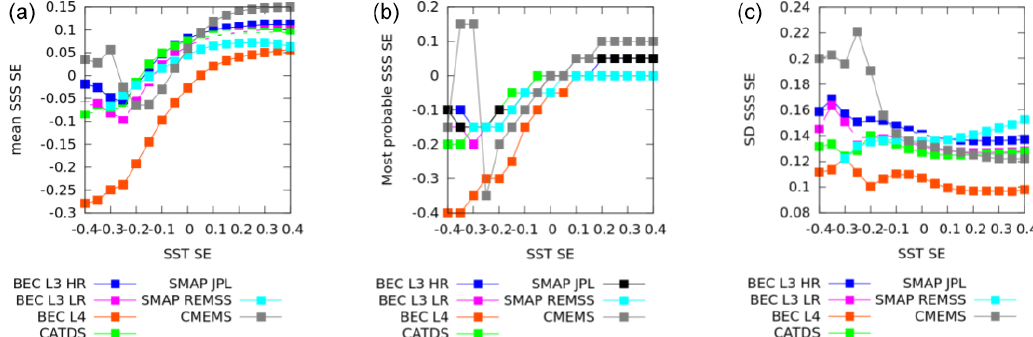
Figure 13. From left to right in the following are shown: the most probable SSS SE value as a function of the SST SEs, the mean SSS SE value as a function of the SST SEs, and the standard deviation of the SSS SEs for each SST